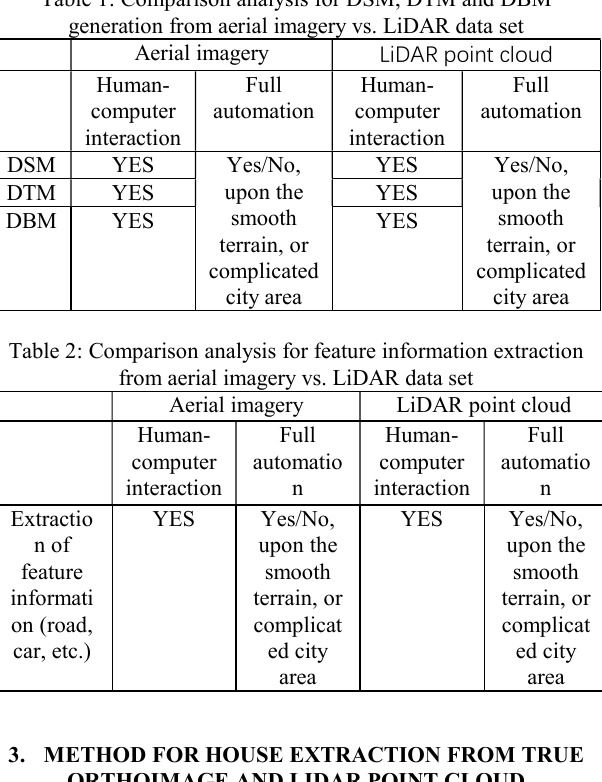
Table 1: Comparison analysis for DSM, DTM and DBM